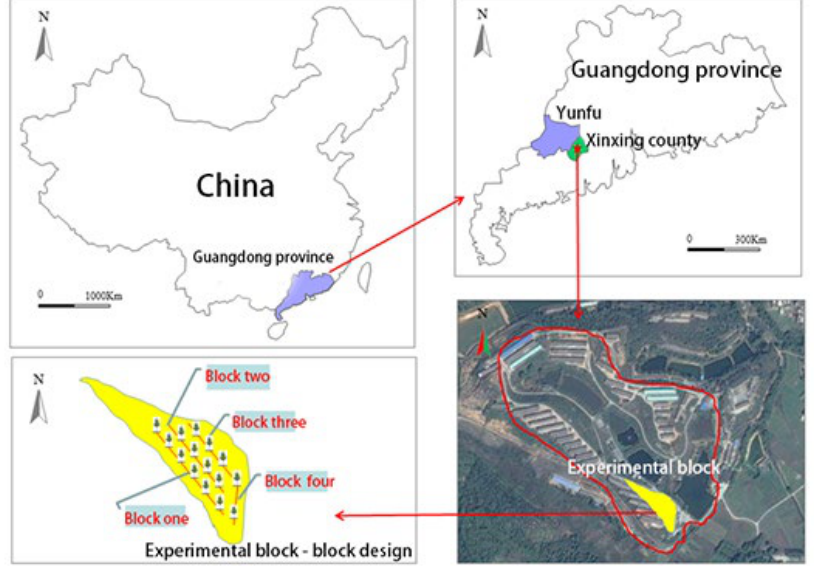
Figure 1. Location of experiment. Table 1. Physicochemical properties of soil.